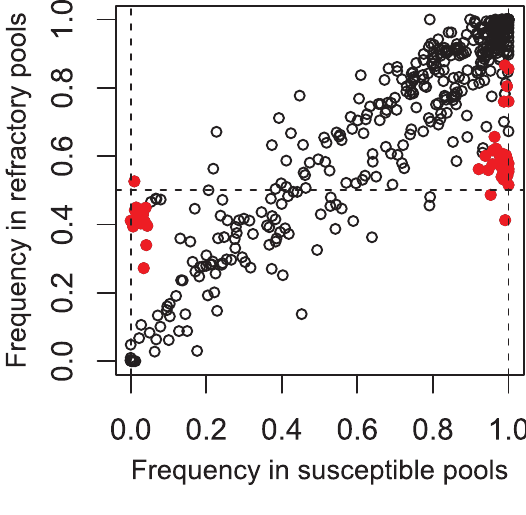
Figure S3 Recombination rate is marginally correlated with average intron length but not with gene density or proportion exonic sequence per scaffold. Recombination rate (cM/Mb) is not correlated with A) gene density or C) proportion exonic sequence and is slightly correlated with B) mean intronic sequence per gene (Spearman correlation, gene density: r = 2 0.012, P =0.784; proportion exonic sequence: r = 2 0.16, P = 0.781; average intron length: r = 2 0.094, P = 0.034). b Figure S4 Mapping of resistance to B. malayi to chromosomal scaffolds. Manhattan plot of the minimum P - values for each scaffold, with the x-axis representing a physical map created from the linkage map. The segregation pattern suggests a single locus (Figure 6A), however mapping of significant markers to all three chromosomes suggest that misassemblies remain. This pattern is removed by only plotting markers from contigs used to generate the linkage map (see Figure 6B). Table S1 Linkage groups were assigned to chromo- somes based on chromosomal location in [ 20 ] . Each cell value represents an individual scaffold. Chi-squared test, X 2 =95.6, df = 4, p , 0.0001. Table S2 Linkage map of Ae. aegypti with positional information. Chromosome number, centimorgan position,